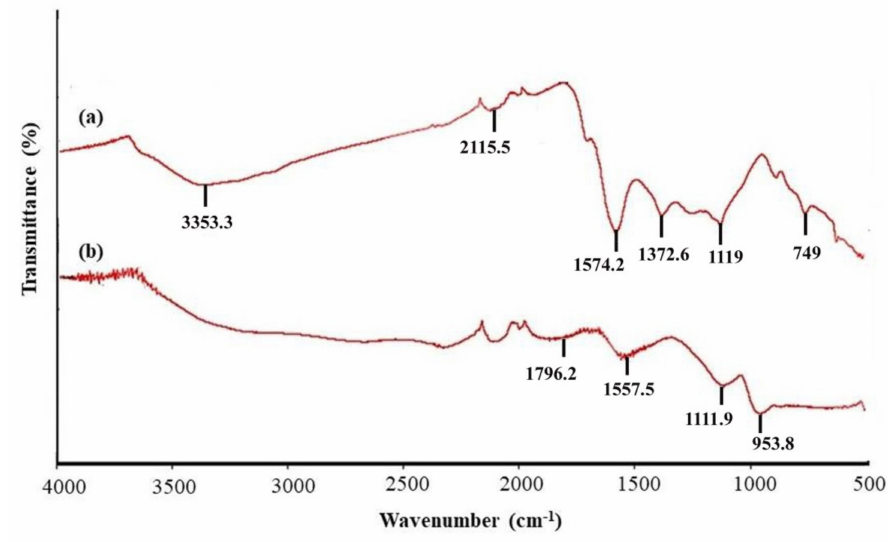
Figure 2. FTIR-ATR spectra for ( a ) NC and ( b ) OPTAC.